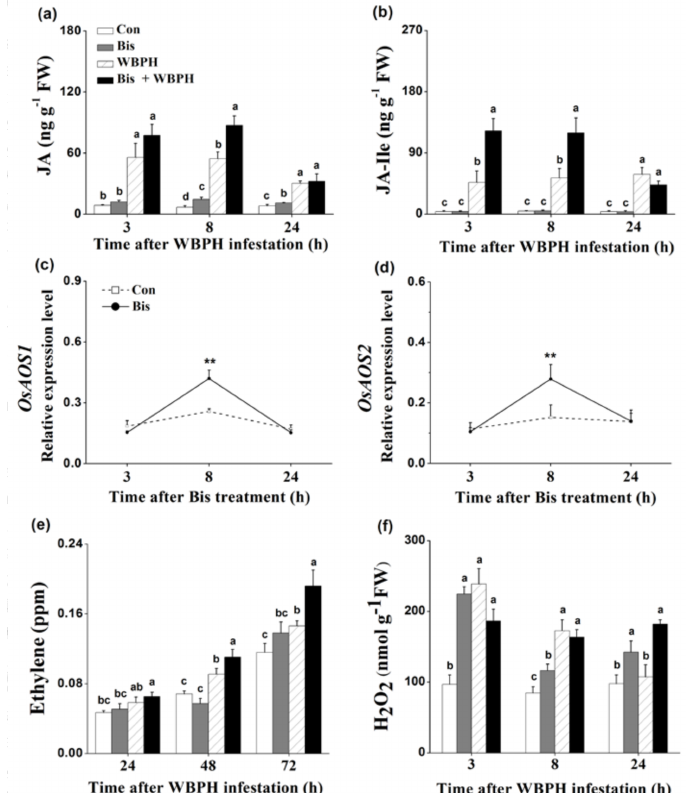
Figure 4. Bismerthiazol elicits JA, JA-Ile, ET and H 2 O 2 biosynthesis. ( a , b ) Mean levels (+SE, n = 5) of JA ( a ) and JA-Ile ( b ) in leaf sheaths of rice plants that had been differently treated for 24 h, at 3, 8 and 24 h after being exposed to WBPH infestation. Con, control plants; Bis, bismerthiazol-treated plants; WBPH, WBPH-infested plants; Bis + WBPH, bismerthiazol + WBPH-treated plants. These treatment methods are described in Materials and Methods; ( c , d ) Mean relative expression levels (+SE, n = 5) of OsAOS1 ( c ) and OsAOS2 ( d ) in leaf sheaths of plants 3–24 h after plants were grown in nutrient solution with 50 mg L − 1 bismerthiazol (Bis) or not (Con); ( e ) Mean levels (+SE, n = 10) of ethylene released from plants that had received different treatments for 24 h, at 24, 48 and 72 h after exposure to WBPH infestation. Treatments are as stated above; ( f ) Mean levels (+SE, n = 5) of H 2 O 2 in leaf sheaths of plants that had received different treatments for 24 h, at 3, 8 and 24 h after exposure to WBPH infestation. Treatments are as stated above. Letters indicate significant differences between different treatments ( p < 0.05, Duncan’s multiple-range test). Asterisks indicate significant differences between treatments and controls at each time point (** p < 0.01; Student’s t